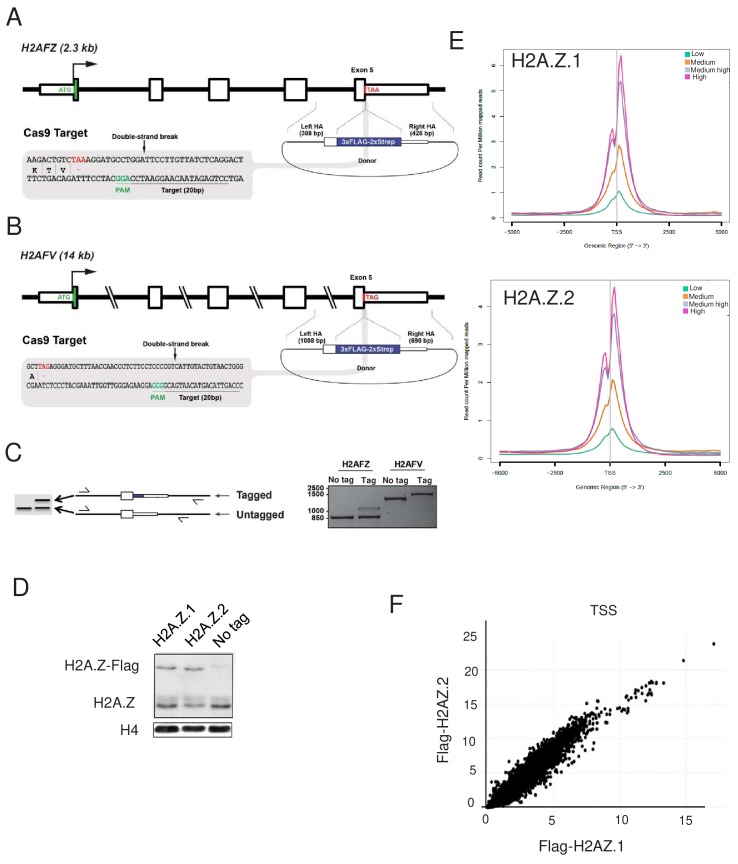
Tagging of H2A.Z isoforms by CRISPR/Cas9 in K562 cells used for characterisation of interactomes.(A) Schematic of the H2AFZ locus (4q23), Cas9 target site, and donor construct used to insert the 3xFlag-2xStrep tag to the C-terminus of the H2A.Z.1 protein. Annotated are the positions of the stop codon (red), the PAM (green) that specifies the cleavage site, the gRNA target sequence, and the left and right homology arms (HA) used for HR-directed insertion. (B) Schematic of the H2AFV locus (7p13), depicted as in (A). (C) Schematic and results of a PCR-based assay (out-out PCR) on genomic DNA to detect targeted integration (TI) of the tag sequence in single-cell-derived K562 clones obtained by limiting dilution. Primers are located outside of the homology arms and are designed to yield a longer PCR product if the tag is inserted, as described in Figure 1—figure supplement 1. Note that the H2A.Z.1-tagged clone is heterozygous, whereas the H2A.Z.2-tagged clone is homozygous. These two clones were used for subsequent analyses since tag expression levels were similar (D) Chromatin-enriched nuclear extracts from the indicated cell line were subjected to a total H2A.Z western blot. (E) K562 cells expressing endogenously tagged H2A.Z.1 or Z2 were subjected to a ChIP-Seq experiments. Protein-coding genes were ranked in 4 classes of equal number based on their expression levels. Meta data showing binding of H2A.Z.1 or H2A.Z.2 ChIP Seq signal around the TSS for the 4 classes of genes are shown. (F) The amount of H2A.Z.1 or Z2 in the −1000 to +1000 from each transcription start site of each protein-coding gene were calculated and plotted against each other. Note the striking correlation between the binding of Z1 and Z2.